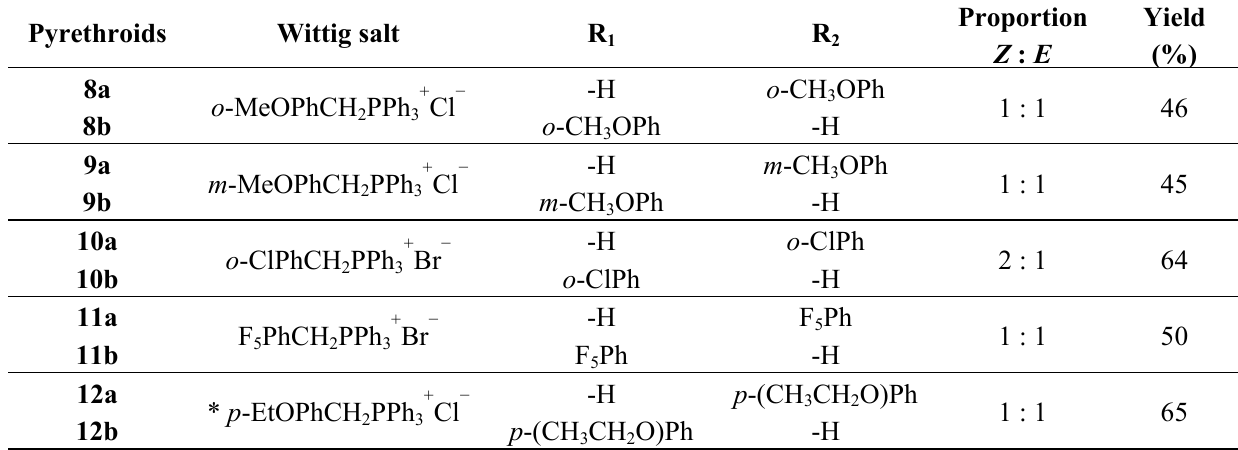
Table 1. Synthesis of the pyrethroids 8 – 12 from 7 : reaction conditions and yields. Pyrethroids Wittig salt